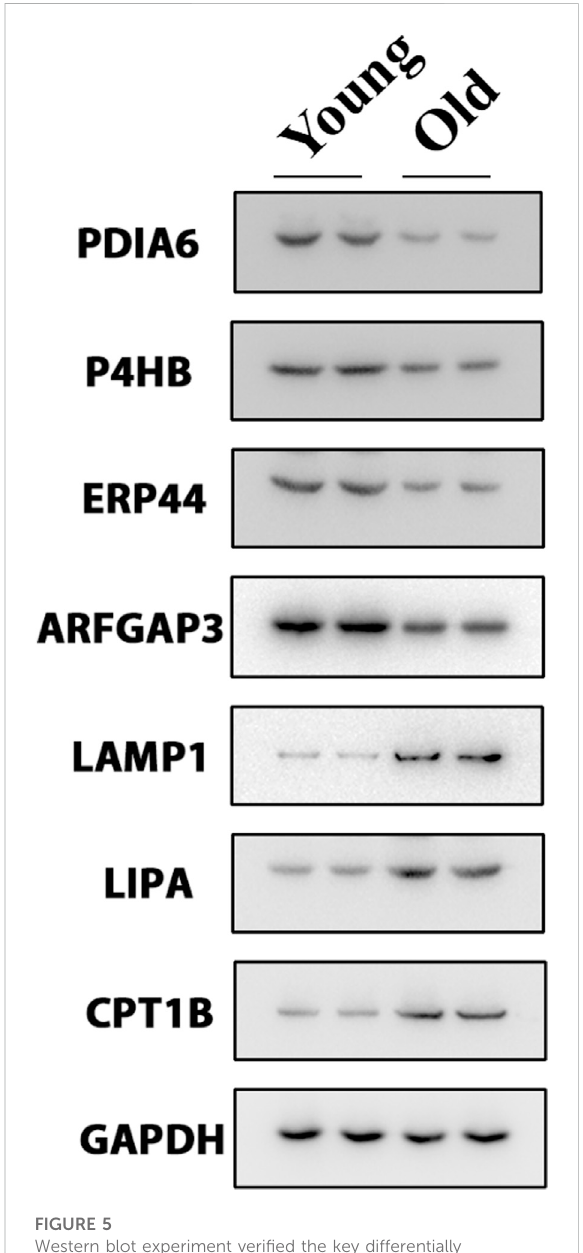
FIGURE 5 Western blot experiment veri fi ed the key differentially expressed